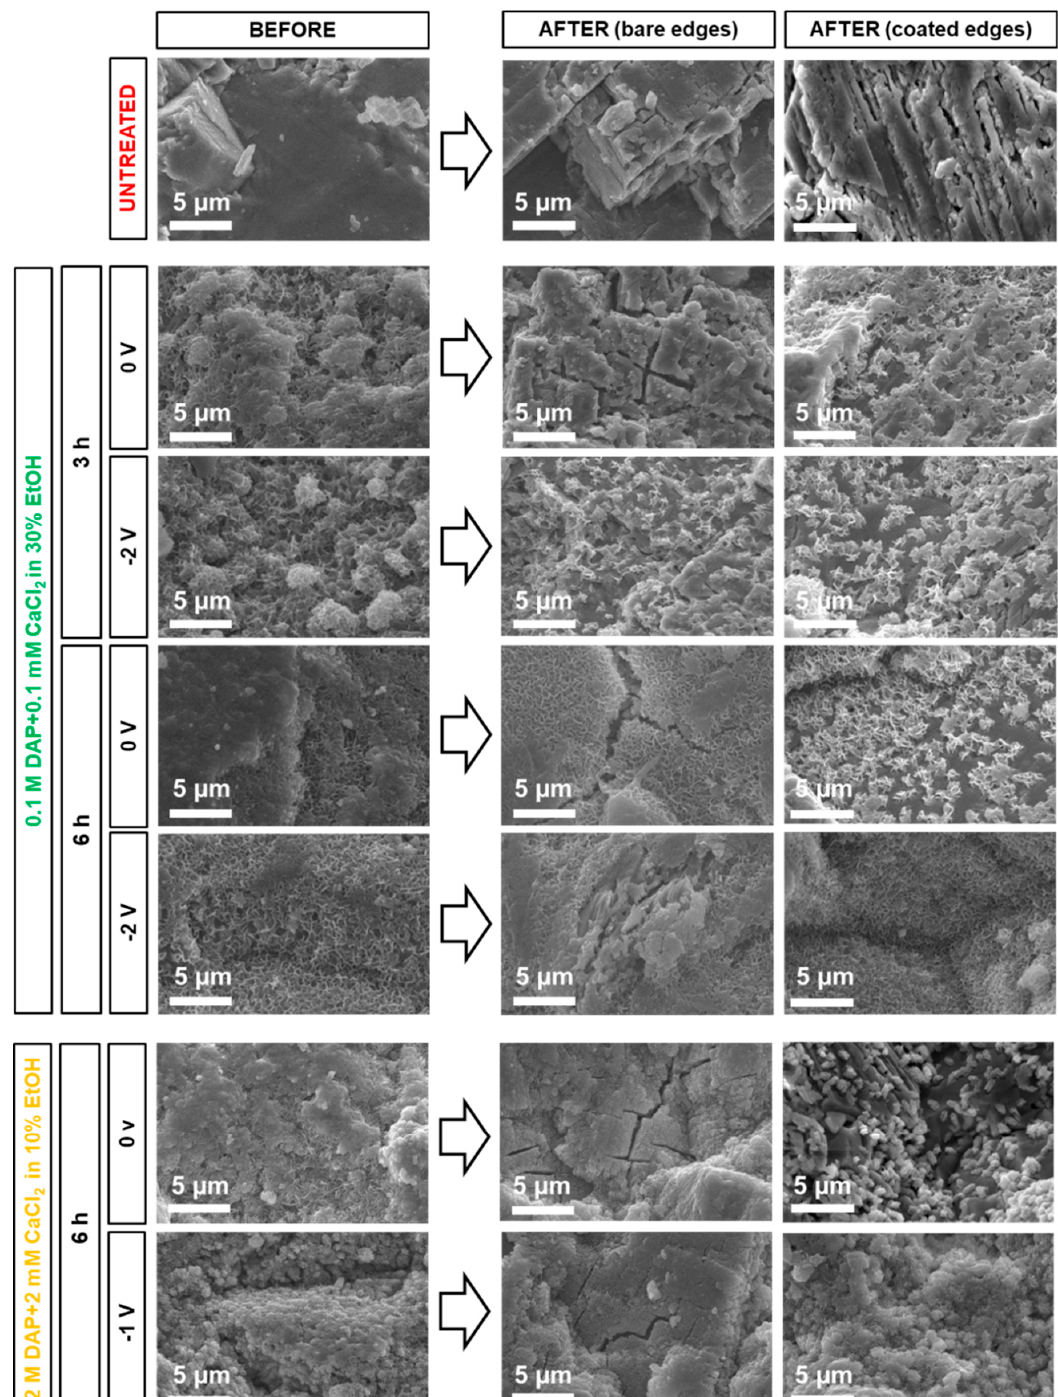
Figure 11. Surface morphology of untreated and treated marble samples, before and after the acid resistance test (samples with either bare or coated edges during the acid test are reported).